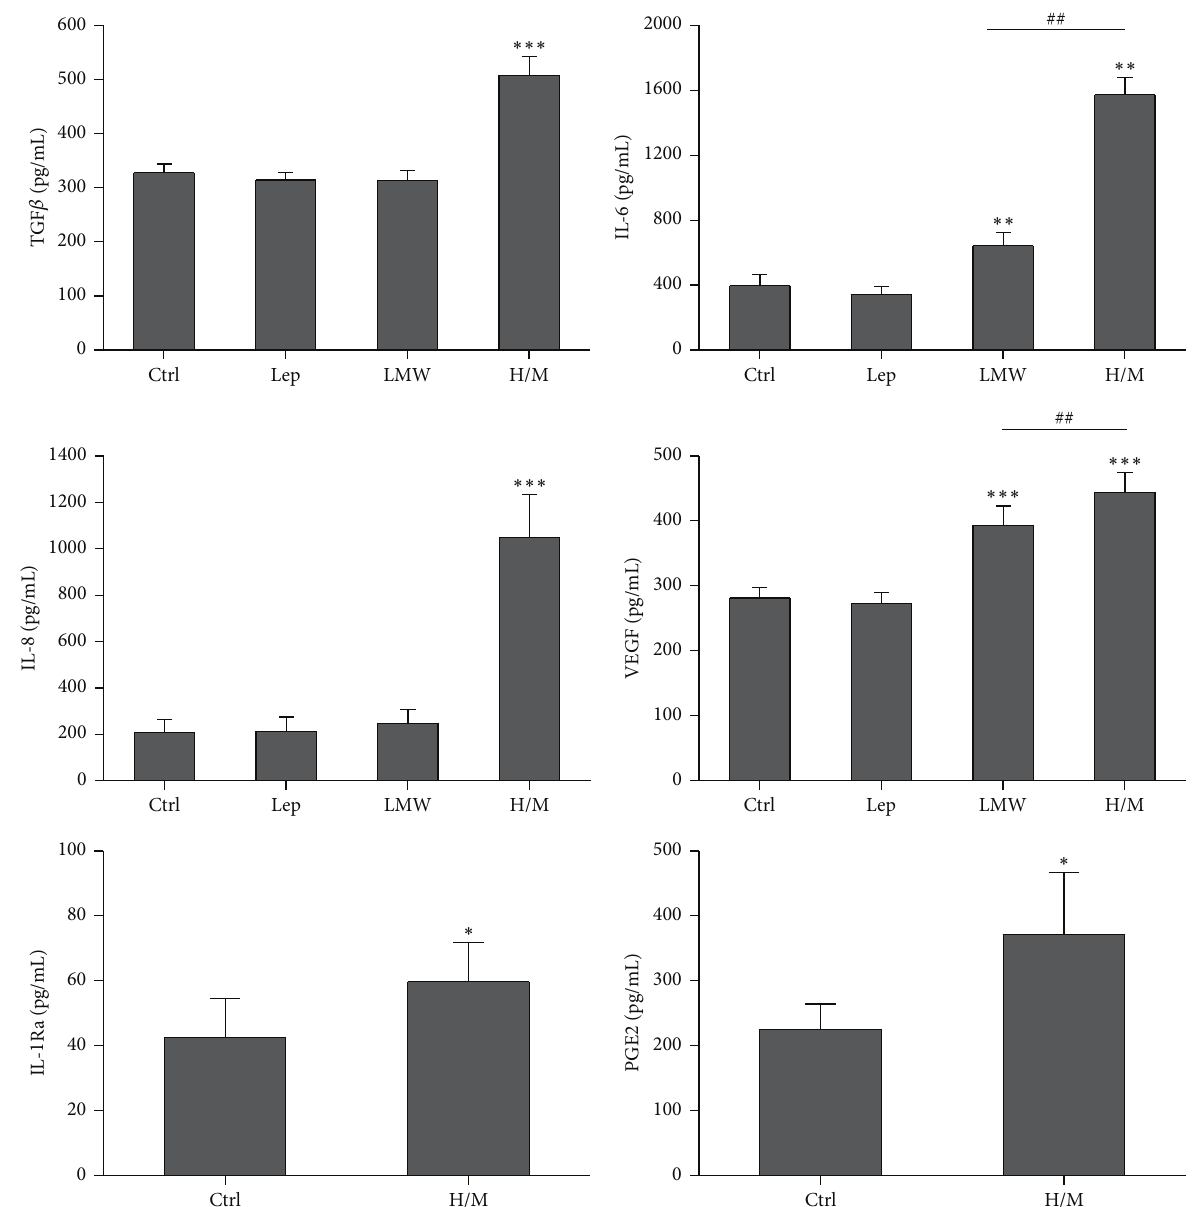
Figure 1: Adipokines effects on secretory activity of ASCs derived from rheumatoid infrapatellar fat pad. Unstimulated (Ctrl) or stimulated with 10ng/mL leptin (Lep), 10 𝜇 g/mL of LMW adiponectin, or 10 𝜇 g/mL of HMW/MMW adiponectin ASCs from RA patients were cultured for 24 h. Concentrations of select factors were measured in supernatants collected from ASCs cultures using specific ELISA tests ( n = 14– 18). Asterisks ( ∗ ) indicate statistically significant differences versus Ctrl; hash marks (#) indicate statistically significant differences between indicated data. ∗ 𝑝 < 0.05 , ∗∗/ ## 𝑝 < 0.01 , and ∗∗∗ 𝑝 < 0.001